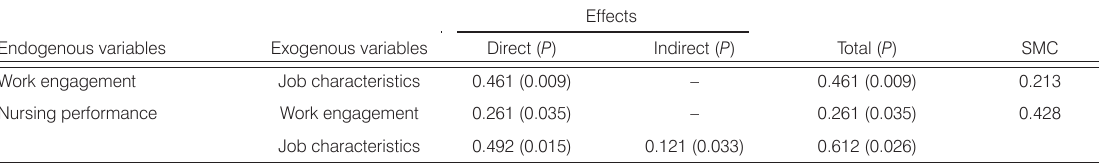
Table 4. Mediating effect of work engagement in the relationship between job characteristics and nursing